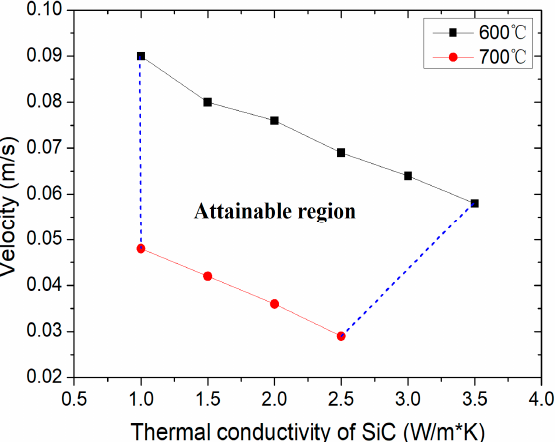
Figure 16. Attainable region for satisfactory outlet temperatures. Table 5. Results summary for the selective scenarios.